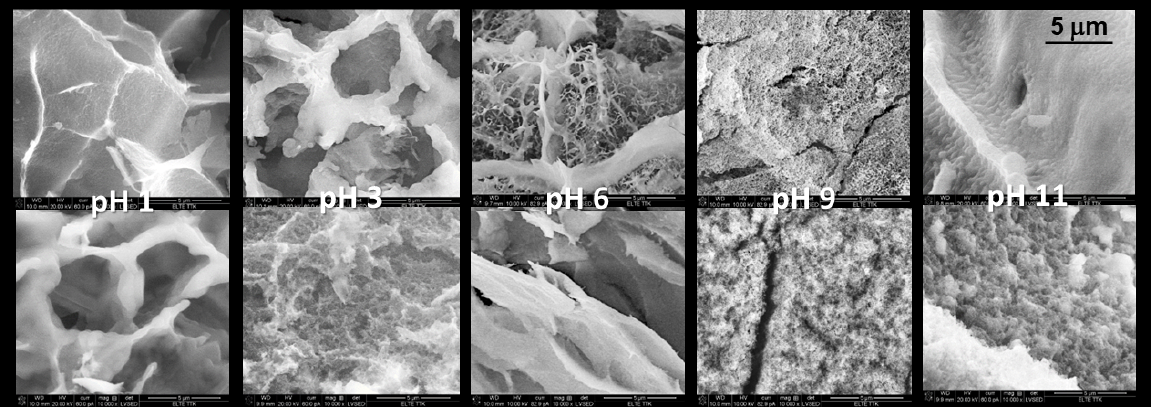
Figure 3. SEM images of cryogel prepared from water glass prepared in different pH. Magnification is 10,000× in every image.